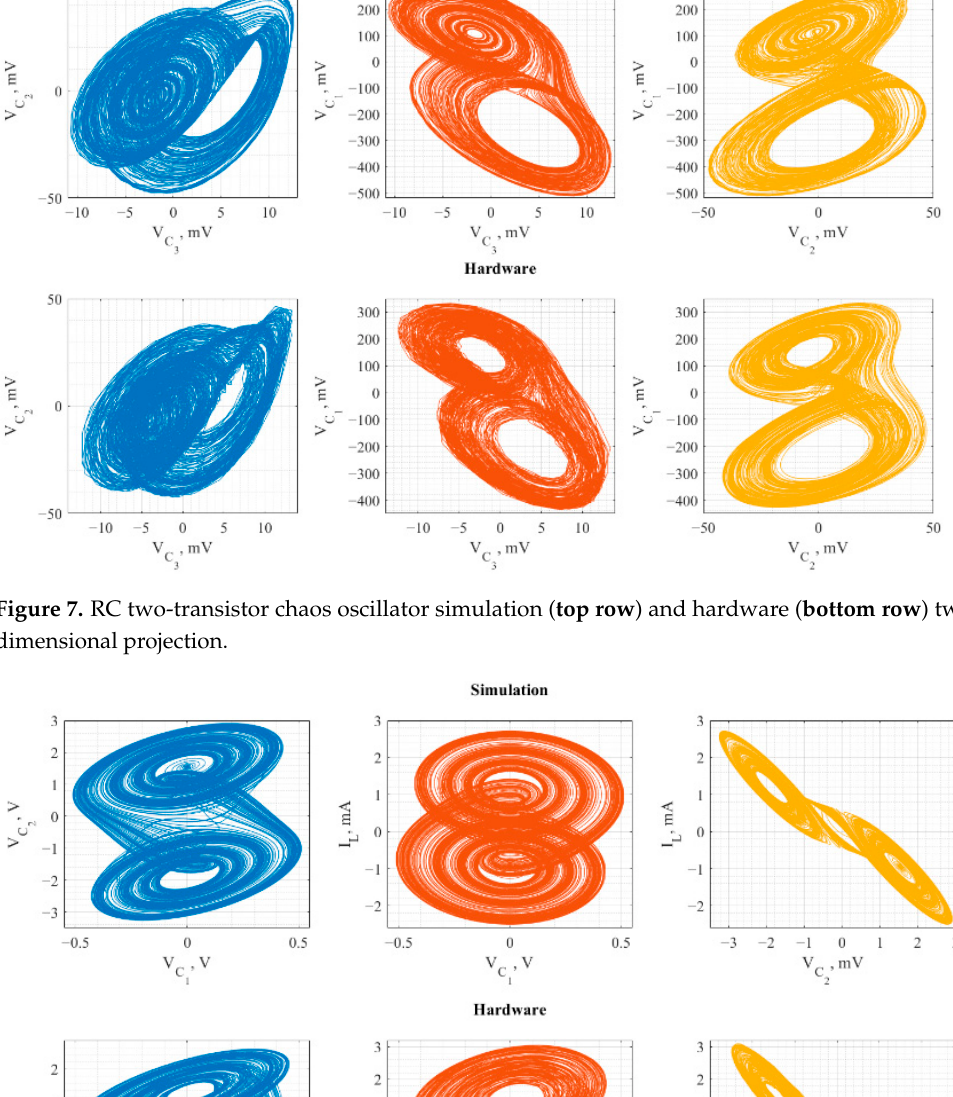
Figure 7. RC two-transistor chaos oscillator simulation ( top row ) and hardware ( bottom row ) two- dimensional projection.